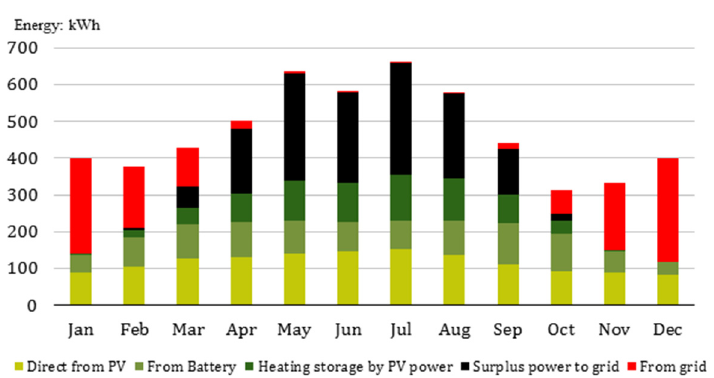
Figure 15. Summary of monthly energy values.